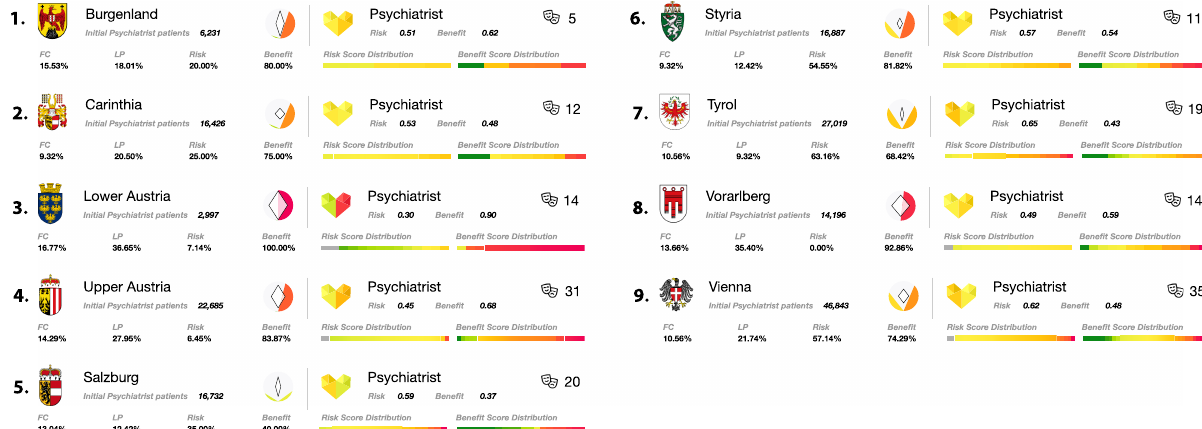
Fig. 4 State-speci fi c result panel. Results for selected medical specialties (here psychiatrists) including averaged resilience indicators, numbers of patients and physicians per federal state and distributions of risk and bene fi t scores for each of the nine federal